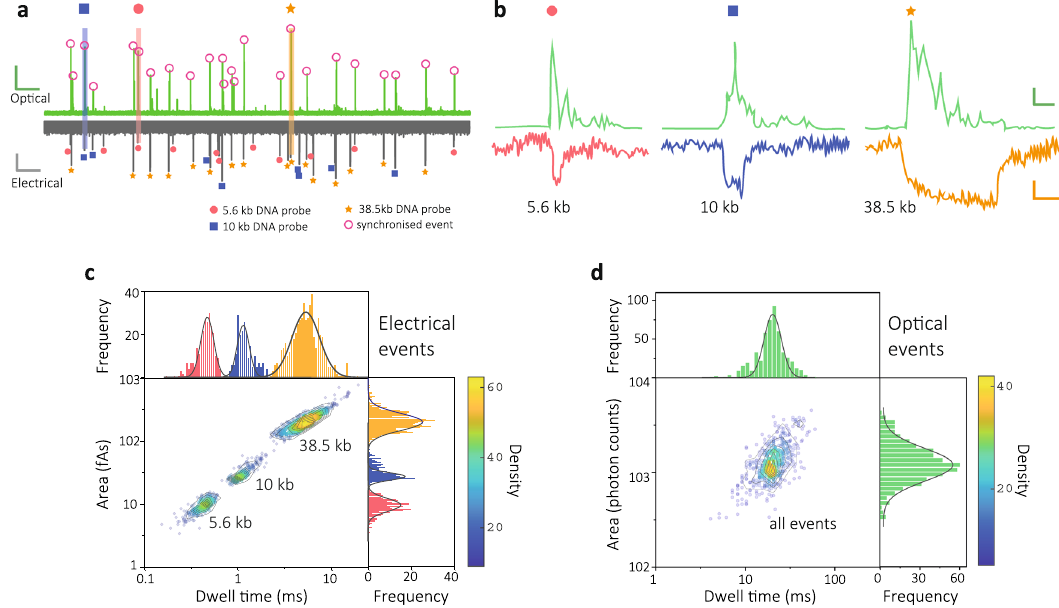
Fig. 2 Length-encoded molecular probes consisting of DNA carriers and molecular beacons. a Representative photon and current time traces for translocation of 5.6, 10 and 38.5 kbp DNA carrier-encoded molecular probes (10 pM each) in the presence of 10× of target miRNAs (let-7a, miR-375-3p and miR-141-3p). Three electrical signals representing the translocation events of 5.6, 10 and 38.5 kbp DNA fragment lengths are marked with a fi lled circle, square and asterisk. Signals in the optical channel with corresponding synchronised events are marked with circles. Scale bar of photon trace (green): vertical, 100 counts/ms, horizontal, 2.5 s. Scale bar of current trace: vertical, 20 pA, horizontal, 2.5 s. b Zoom-in views for the three respective classes of events for size codes of 5.6, 10 and 38.5 kbp molecular probes. Scale bar of photon trace: vertical, 50 counts/ms, horizontal, 10 ms. Scale bar of current trace: vertical, 10 pA, horizontal, 1 ms. c , d Density scatter plots of dwell time vs peak current area for the electrical ( n = 1014) and optical ( n = 507) signals. Three populations can be observed for the electrical events that represent the three DNA fragments, while only one population is observed for optical events. Histograms are fi t using a Gaussian function. All the translocations were performed in 100 mM KCl buffer (5 mM MgCl 2 , 10 mM Tris-HCl, 1 mM EDTA, pH = 8.0) at an applied potential bias of − 300 mV with laser power of 90 ± 4 µ